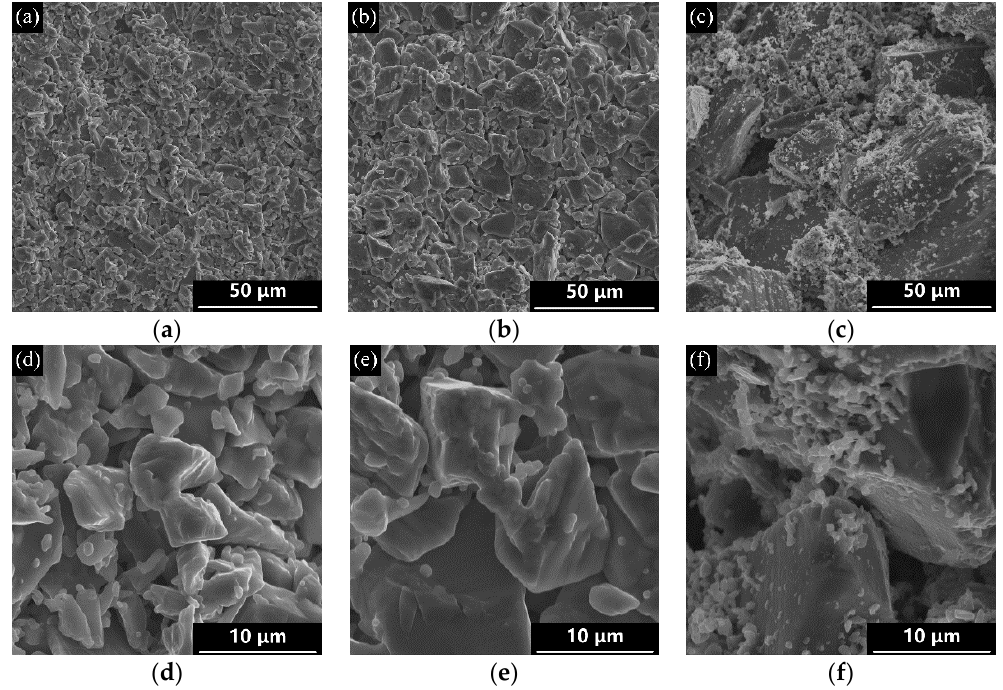
Figure 3. SEM images of porous L-SiC ceramics with different particle sizes of initial coarse SiC powder: ( a , d ) 7 μ m; ( b , e ) 15 μ m; ( c , f ) 41 μ m.